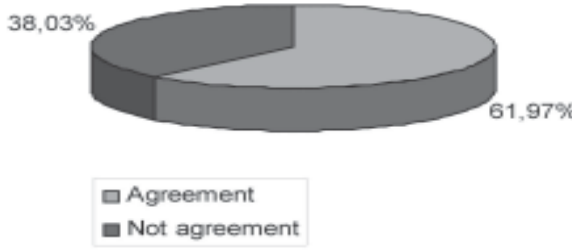
FIGURE 3- Percentage of agreements of diagnosis of chronic apical periodontitis after clinical radiographic